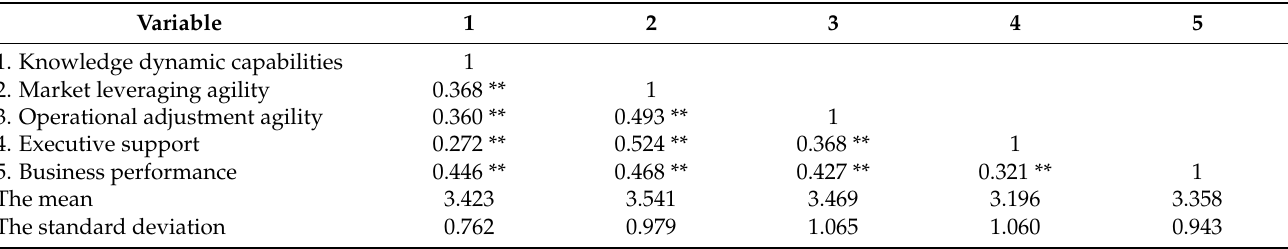
Table 3. Descriptive statistics and correlation